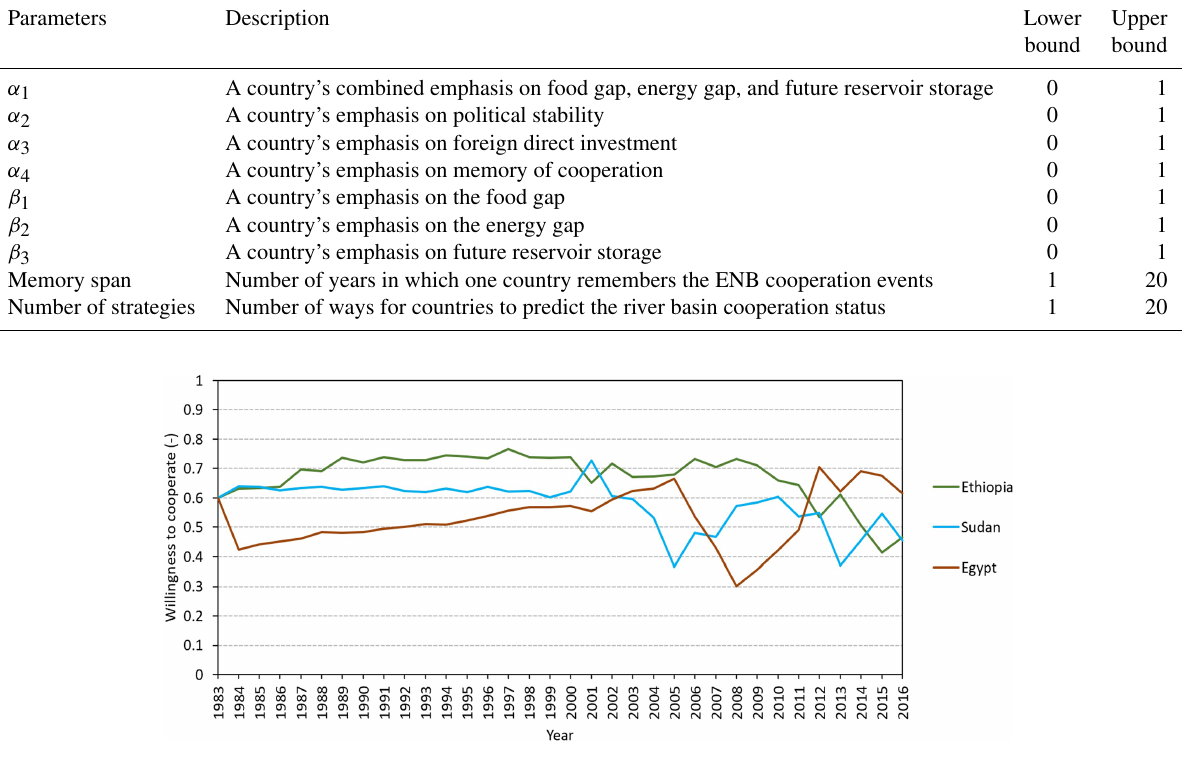
Figure 6. Simulated riparian countries’ willingness to cooperate (WC) from 1983 to